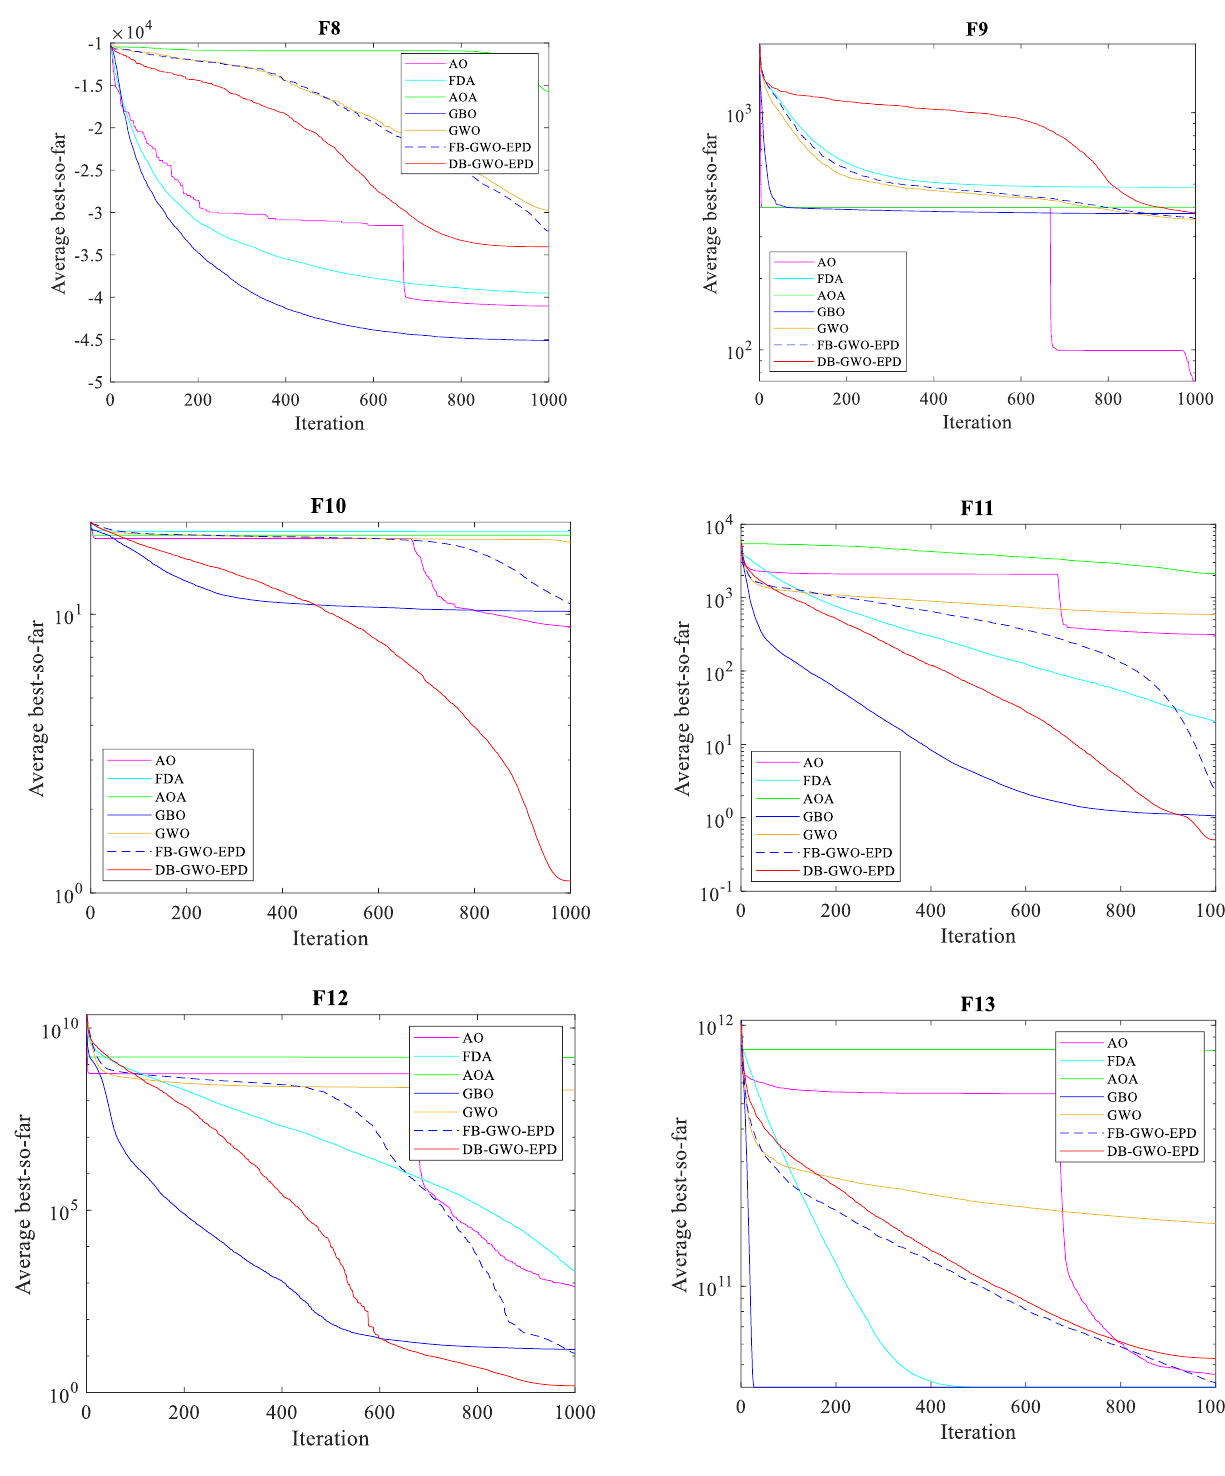
Figure 3. Convergence curves plotted for the algorithms on the multi-modal shifted benchmark functions. Table 5. Results of the DB-GWO-EPD and its rivals on the shifted benchmark functions, with n = 100.